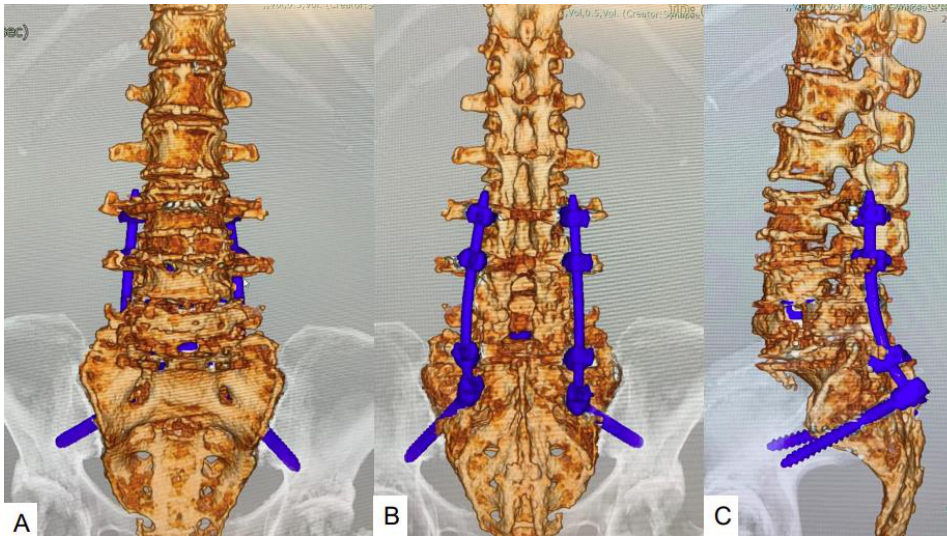
Figure 4. CT at final follow-up at one year. ( A ) Anteroposterior 3D CT; ( B ) Posteroanterior 3D CT; ( C ) Lateral 3D CT.